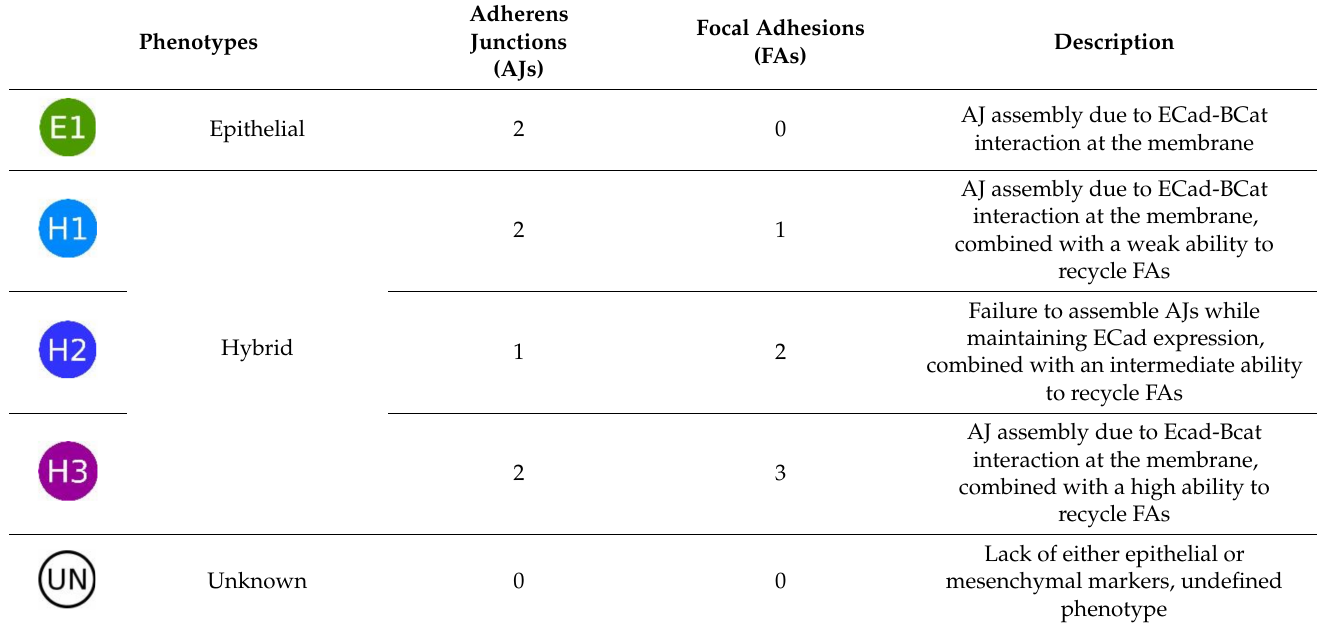
Figure 2. Regulatory network of cell adhesion properties controlled by the micro-environment during EMT. Inputs from the TME are denoted in grey, epithelial markers are indicated in green, whereas mesenchymal markers are in dark brown. Oval nodes denote Boolean components, rectangular ones denote multi-valued components. Green arrows denote activatory interactions, red blunt arrows denote inhibitory interactions. Two model read-outs provide the states of Adherens Junction (AJ) assembly and of Focal Adhesion (FA) recycling. Table 1. The attractors of the logical EMT model identify eight phenotypes characterised by the values of the read-out components AJ and FA. The first column indicates the phenotypes and their classification into: epithelial, hybrid, unknown, or mesenchymal based on the values of the read-outs AJ and FA. The second and third columns indicate the values of the read-outs AJ and FA, respectively. The last column describes each